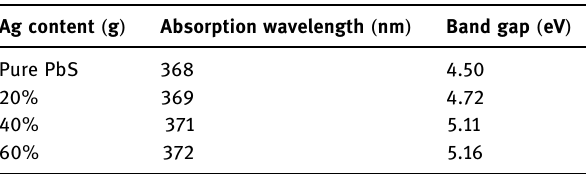
Table 3: Band gap for pure PbS and Ag:PbS at ( a ) 20%, ( b ) 40%, and ( c ) 60% Ag content ( g